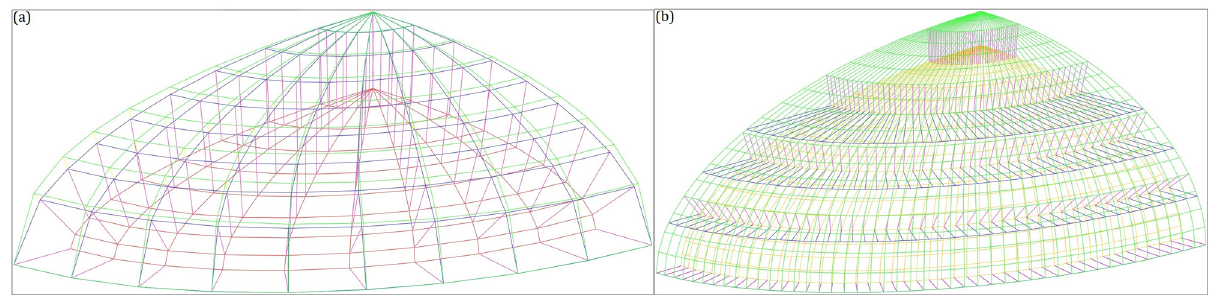
Figure 5: Fragments of the surfaces S u v ,